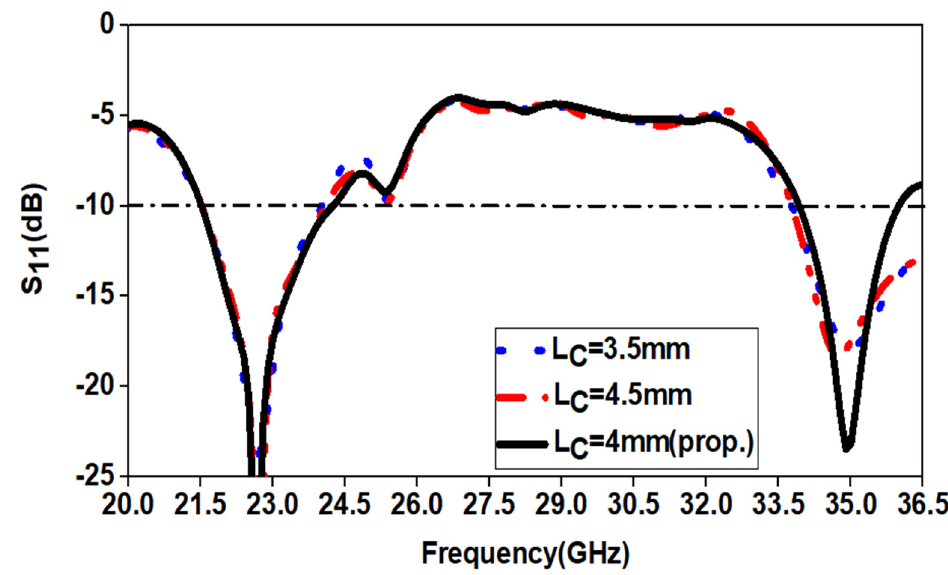
Figure 12. Analysis of variation in the length of second type ground cut L C .